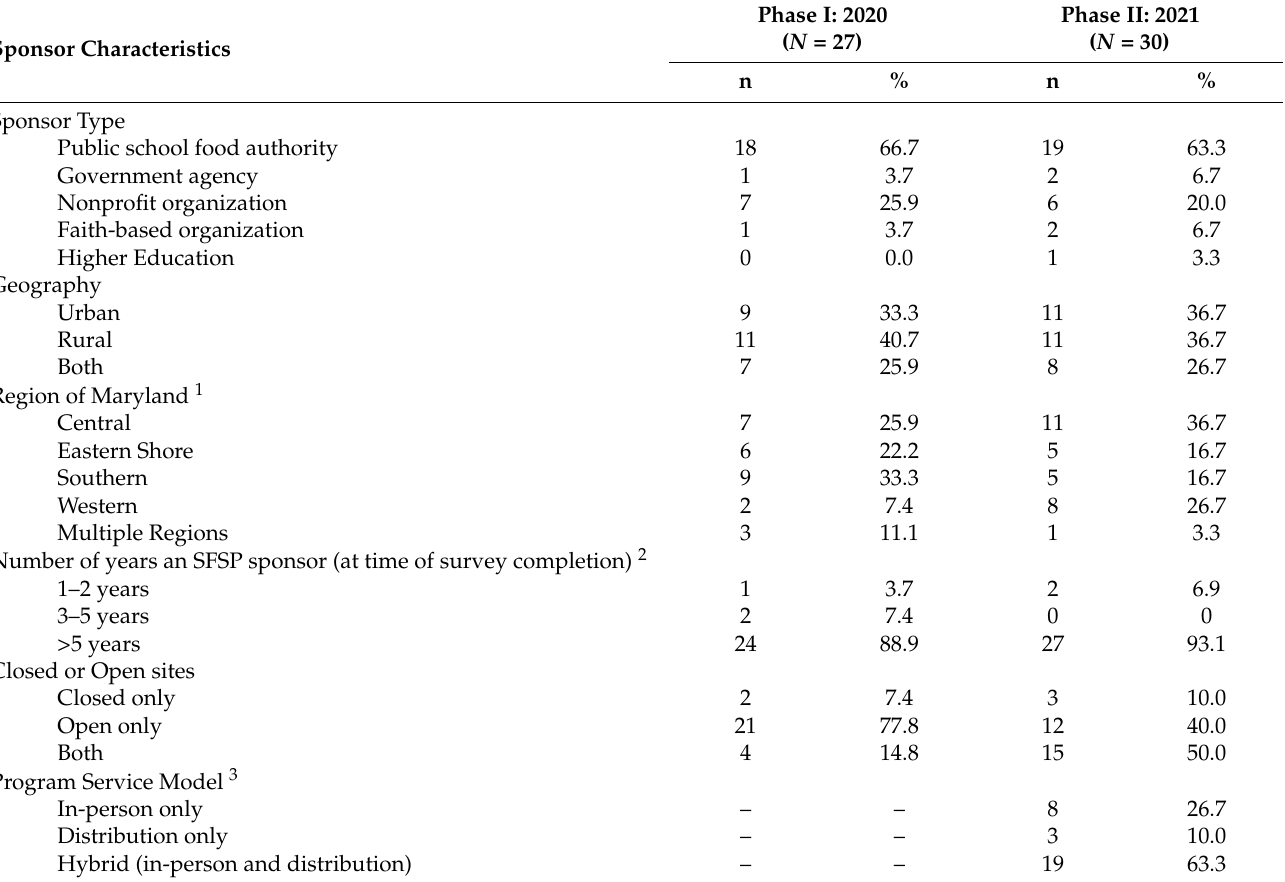
Table 1. Maryland 2020 and 2021 Summer Food Service Program (SFSP) sponsor survey respondent